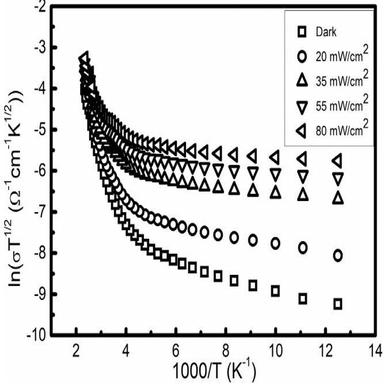
The variation in the Eg values with temperature. Fig. 6. The temperature dependence of calculated dark and illuminated conductivity values under the illumination intensity of 20, 35, 55 and 80 mW/cm2 .